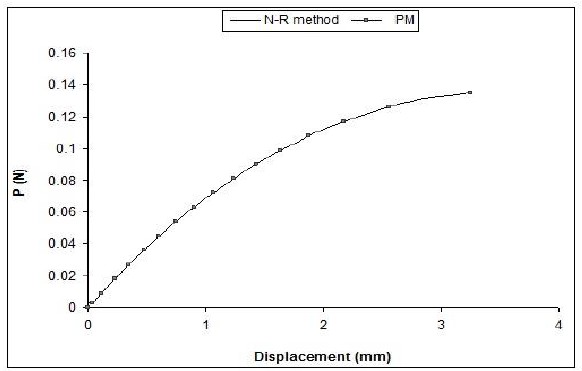
Figure 3. Space truss with 24–members, all dimensions are in mm. Table 1. Comparison of the computational cost and iteration number